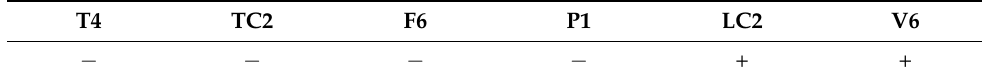
Table 4. States of abnormal